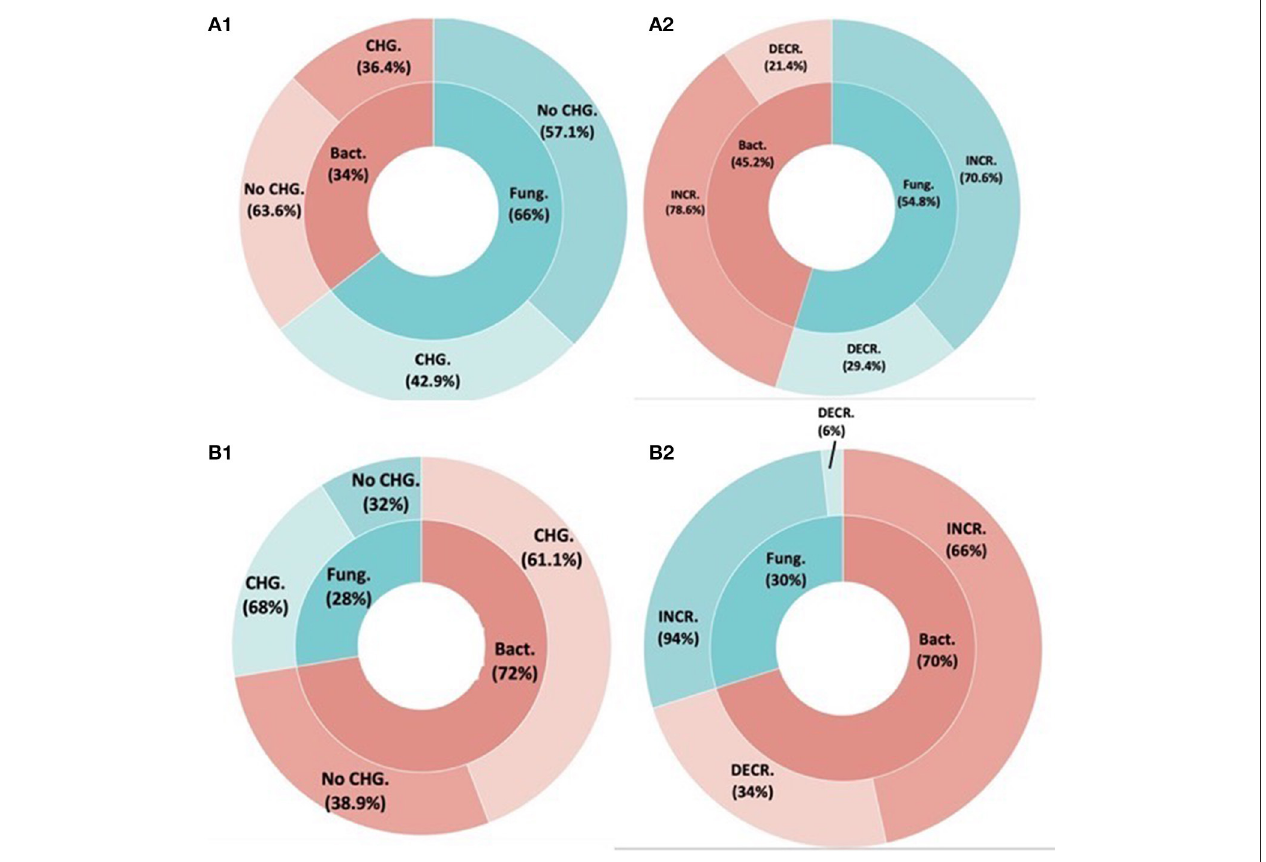
FIGURE 3 | Effect of bacterial and fungal inoculants on the native (A) fungal and (B) bacterial communities. (A1,B1) The inner rings demonstrate the inoculant identity (bacterial or fungal). The outer rings demonstrate the proportion of studies that found a change or did not find a change on the resident fungal and bacterial communities. (A2,B2) Boxed pie charts demonstrate the directional community changes per inoculant type (blue = fungal inoculants and red = bacterial inoculant) for the studies that showed SMC changes following inoculation.